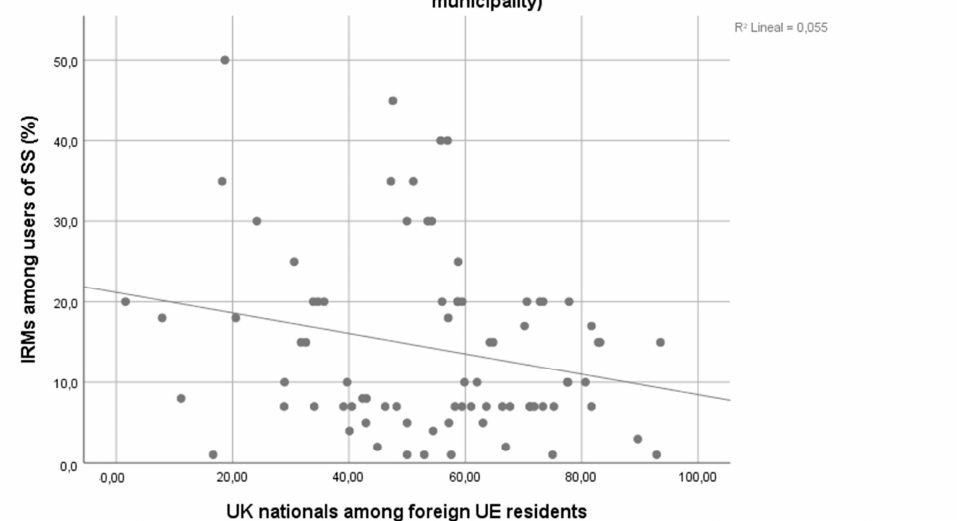
Figure 4. Retirement migrants among users of Social Services and share of UK elderly citizens among the elderly. Source : Own elaboration with primary data from our telephonic survey with Social Services’ coordinators and data from Local Registers. Each dot is a municipality. In the horizontal axis one can see the share of UK nationals among foreign residents. In the vertical axis one can see the share of European elderly among claimants of the Social Services. The line is the regression line for a linear regression model with the two variables. Hypothesis 3. UK citizens are more present among users of local Social Services even in munici- palities that are key destination spots for Germans. According to our database, in municipalities where German citizens are more than 15% of the registered elderly foreigners, they are also present among users of Social Ser- vices (see Figure 5). In municipalities where they are more than 30% of elderly foreign residents, they are the main group of retirement migrants using the Social Services. The hypothesis is hence not con fi rmed. Germans do register and do use Spanish Social Ser- vices. However, similar to the English case, the use that German retirees make of public Social Services varies a lot across municipalities and it is not related to the share of Ger- mans among the foreign elderly registered as residents.